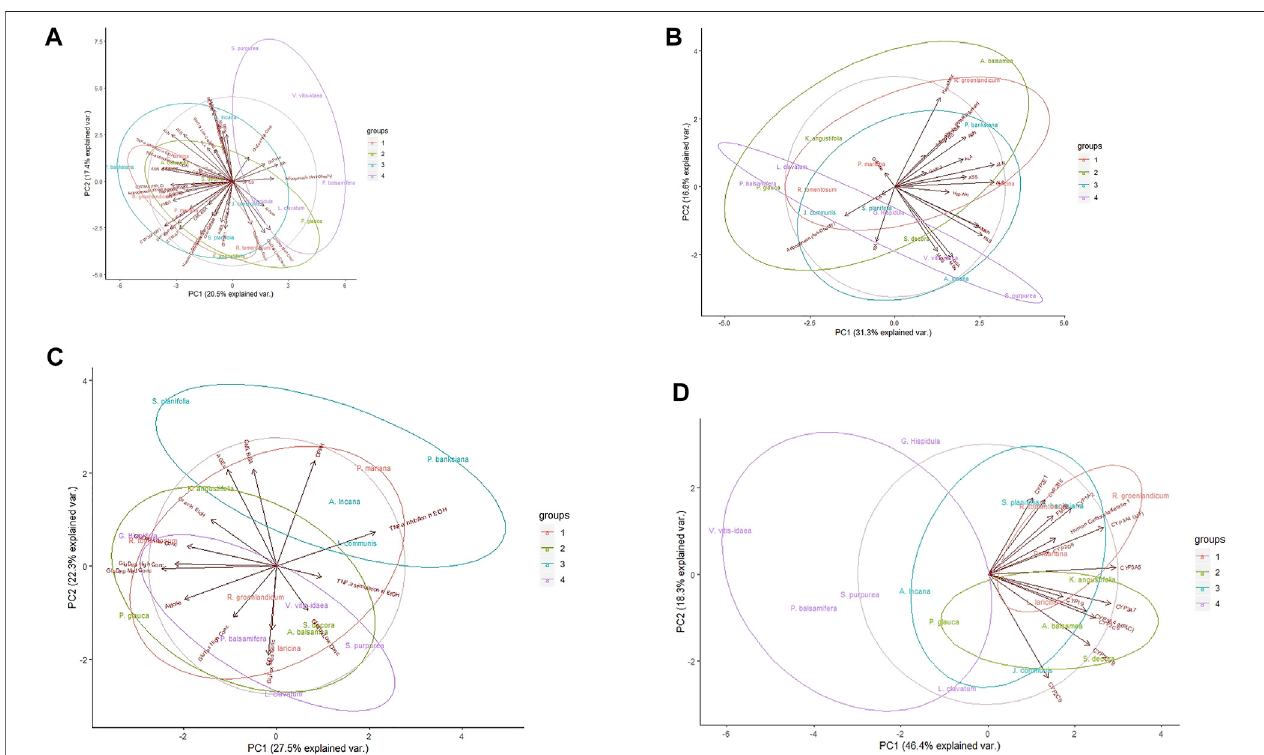
FIGURE1| PrincipalcomponentanalysisofCreemedicinalplantbiologicalactivitysubgroups.Groupingsre fl ectrankingsbasedonSyndromicImportanceValues assignedtoeachplantthroughinterviewswithCreeelders;groupsquartilesrefertothedegreeofrelationshipofplantusewithdiabetessymptoms. (A) Analysisusingall evaluated bioassays. (B) Analysis using primary anti-diabetic bioassays. (C) Analysis using secondary anti-diabetic bioassays. (D) Analysis using herb-drug interaction bioassays. Central circles represent 95% con fi dence interval on full data sets. Ellipses indicate 95% con fi dence intervals on